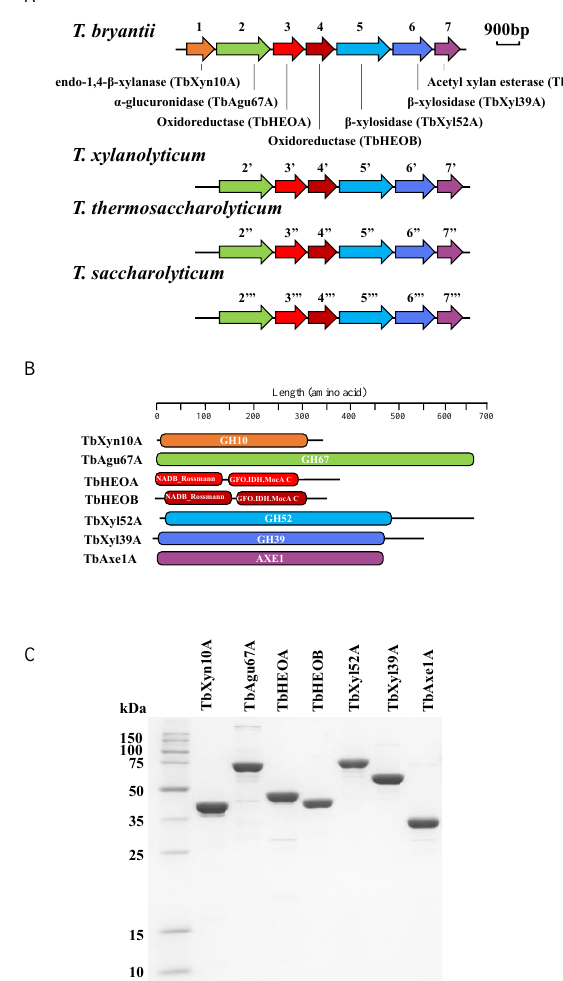
Figure 3. The Thermoanaerobacterium bryantii hemicellulase gene cluster. ( A ) The arrangement of genes in the T. bryantii hemicellulase gene cluster is similar but not identical to those of T. xylanolyticum , T. thermosaccharolyticum , and T. saccharolyticum . ( B ) Schematic representation of the modular architecture of the putative enzymes encoded by the T. bryantii hemicellulase gene cluster. GH10: glycoside hydrolase family 10 module; GH67: glycoside hydrolase family 67 module; NADB_Rossmann: Oxidoreductase family, NAD(P)-binding Rossmann fold, which is also